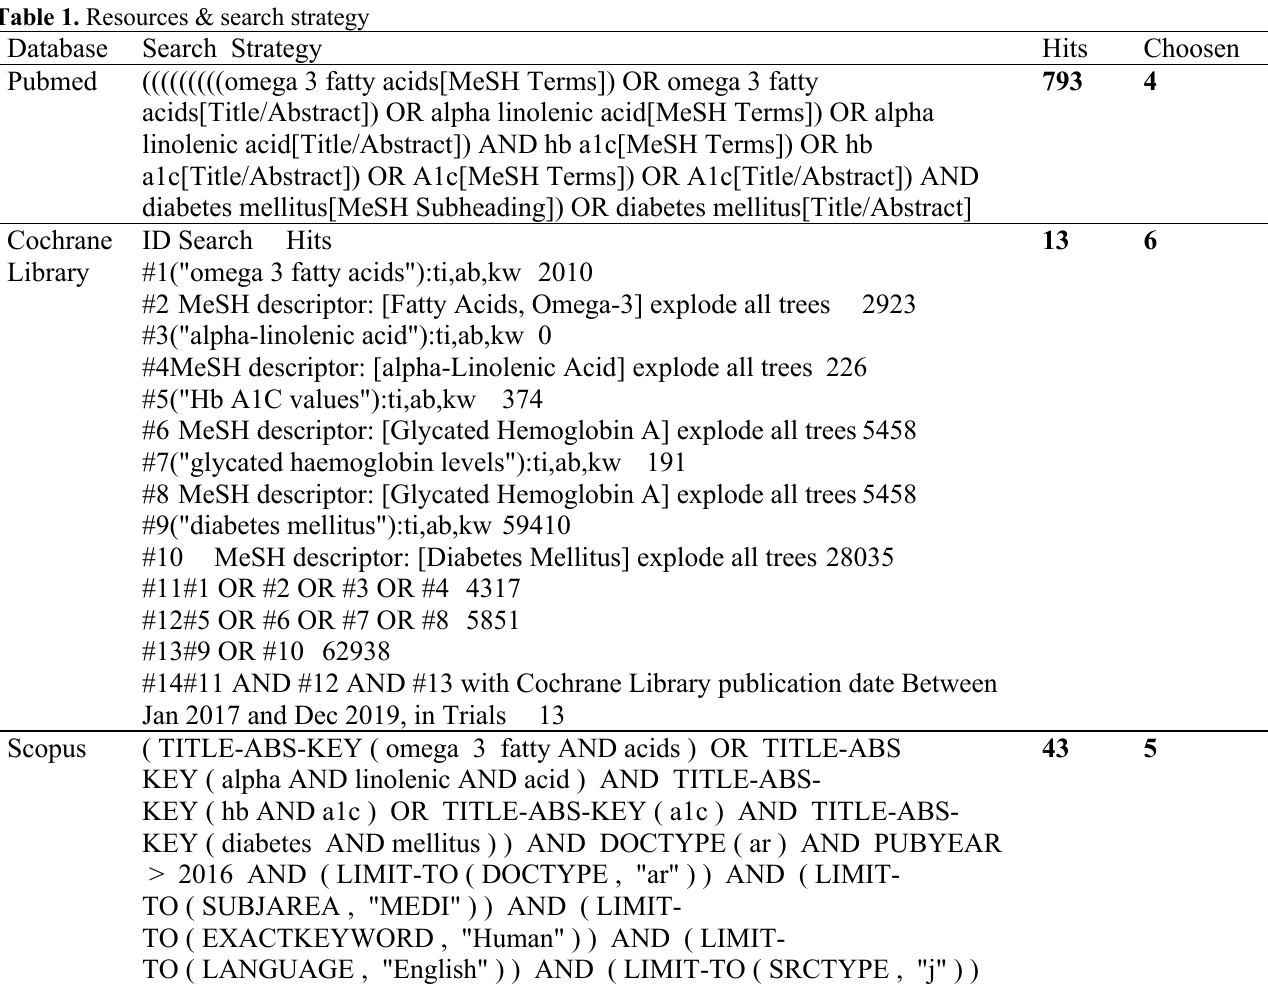
Table 1. Resources & search strategy Database Search Strategy Hits Choosen